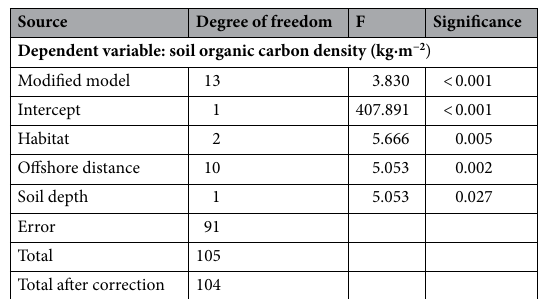
Table 1. Between-subjects effects of different variables on soil organic carbon density (SOCD, kg·m −2 ). R 2 = 0.354 (Adj R 2 = 0.261).